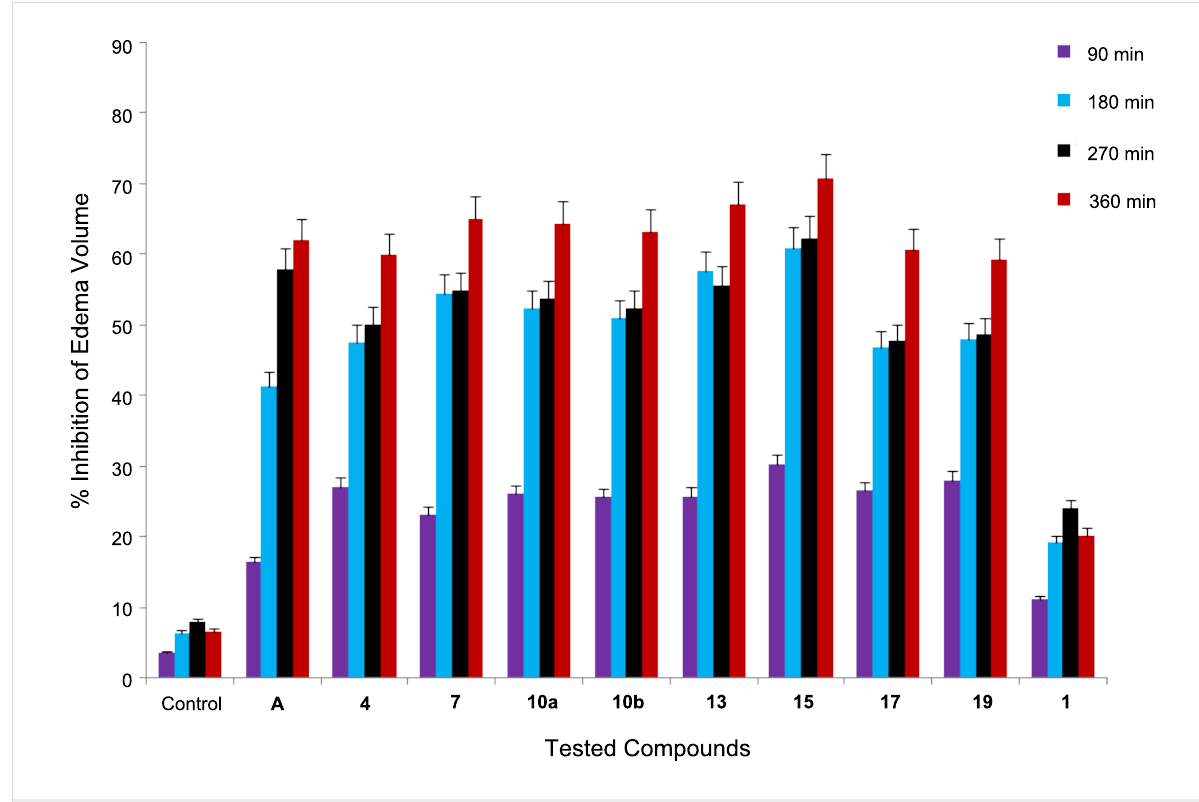
Figure 1: Percentage inhibition of granuloma for the tested compounds at a dose of 50 mg per kilogram body weight after the given time intervals. Error bar: